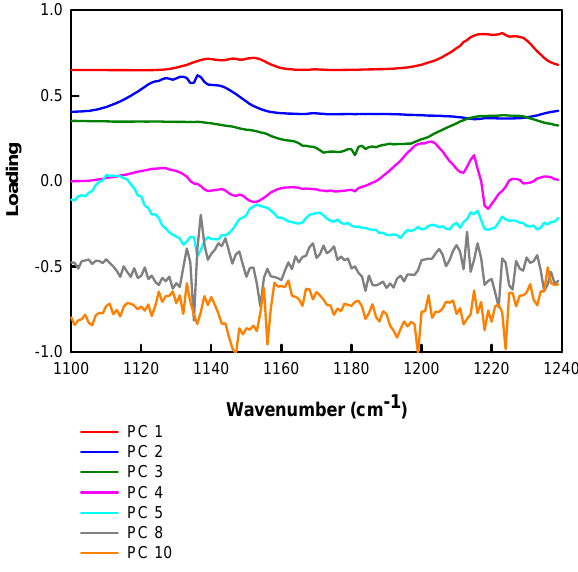
Figure 8. Loadings 1–5, 8, and 10 for the PLS2 model (offset added for clarity).